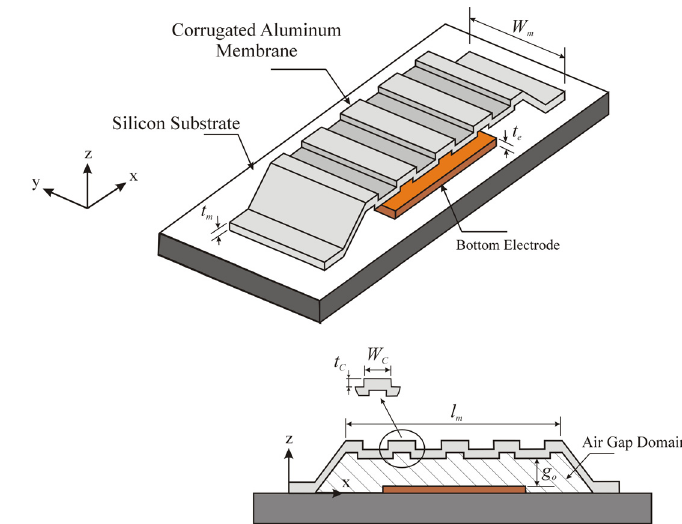
Figure 2. Corrugated RF MEMS